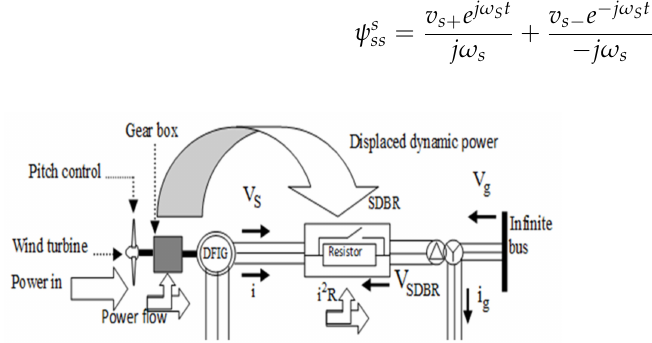
Figure 9. Dynamics of SDBR in DFIG wind